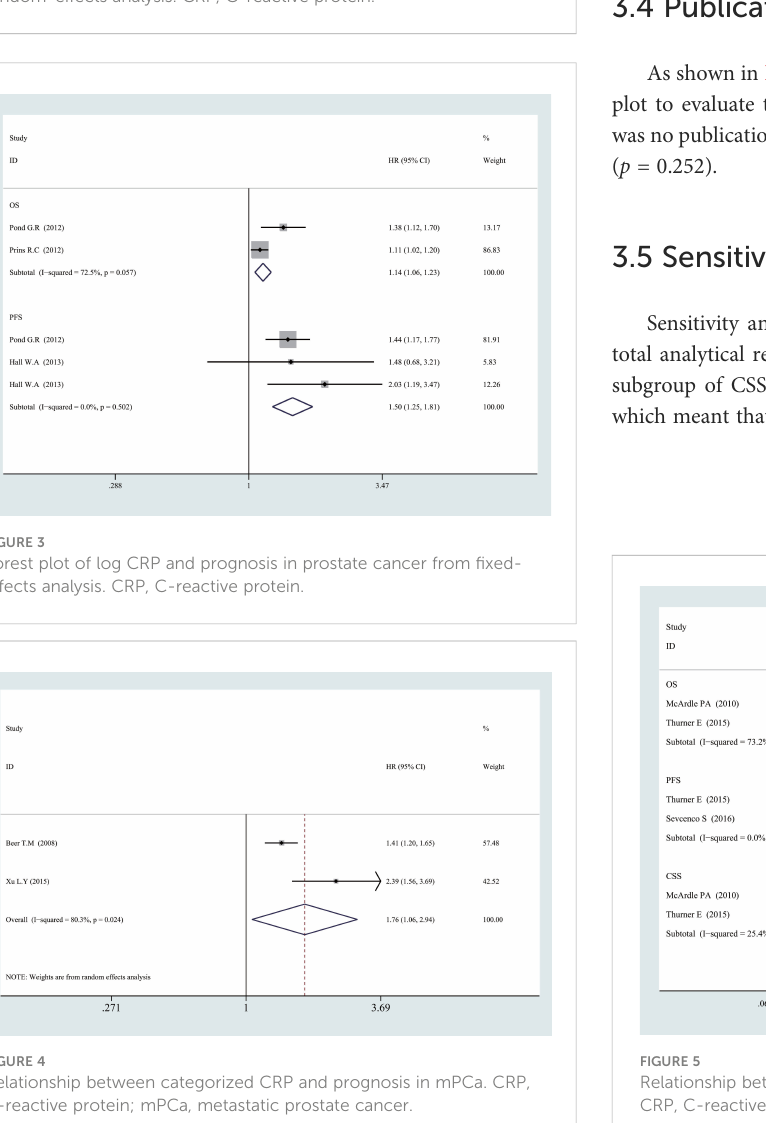
FIGURE 2 Forest plot of categorized CRP and prognosis in prostate cancer from random-effects analysis. CRP, C-reactive protein.